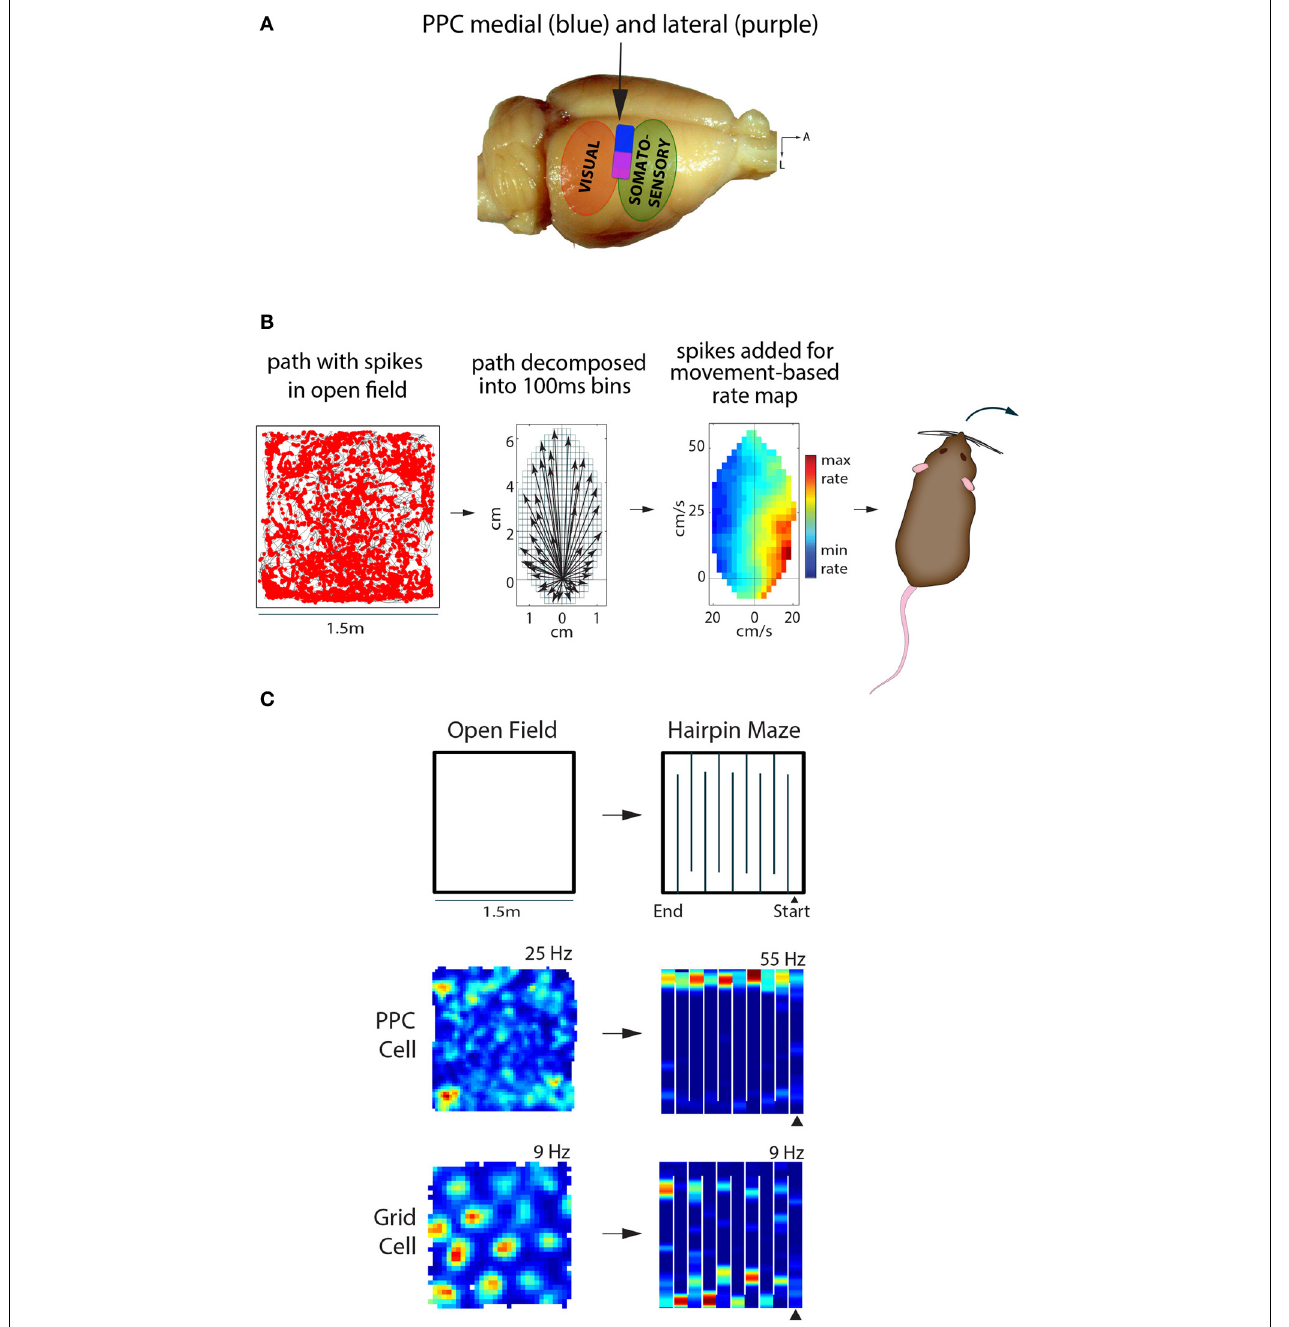
FIGURE 1 | Posterior parietal cortex (PPC) in the rat represents self-motion states, while entorhinal grid cells represent space. (A) The rat PPC is located rostral to primary and secondary visual cortical areas, and caudal to somatosensory cortex ( ∼ 3.5–5mm posterior of Bregma). Medial PPC ( ∼ 1.5–2.75mm lateral of midline) is drawn in blue, while lateral PPC ( ∼ 2.75–4.5m lateral) is in purple; adapted from Paxinos & Watson “The Rat Brain,” 6th edition. (B) Left, the path of a rat foraging in an open arena is shown in black, with spikes from a PPC neuron overlaid as red dots. Middle, the animal’s path is decomposed into movement vectors calculated in 100ms time bins to resolve elementary linear and translational motion states during foraging; the schematic illustrates the population vector sum of all motion